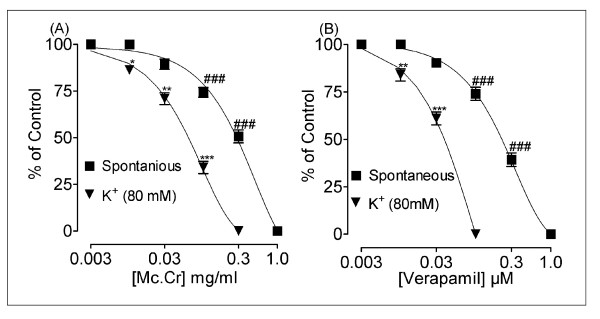
Inhibitory effect of the (A) Mc.Cr and (B) verapamil on spontaneous and high K+-induced contractions in isolated rabbit jejunum preparations ###P < 0.001; shows a comparison of concentration-dependent effects (specified effect compared with the effect of preceding dose) on spontaneous contractions, whereas **P < 0.01; ***P < 0.001; show comparisons of relaxant effects on K+ (80 mM)-induced contractions.